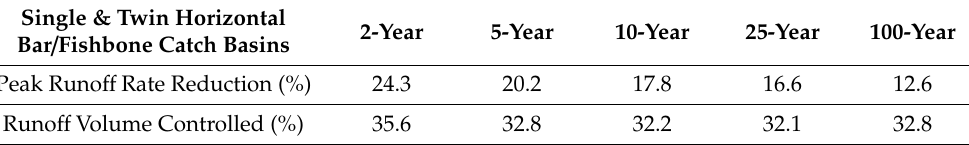
Figure 8. Hydrographs of a single and twin horizontal bar/fishbone catch basin; ( a ) inlet and outlet hydrographs; and ( b ) bypassed hydrographs. Table 4. Runo ff control performances of single & twin horizontal bar / fishbone catch